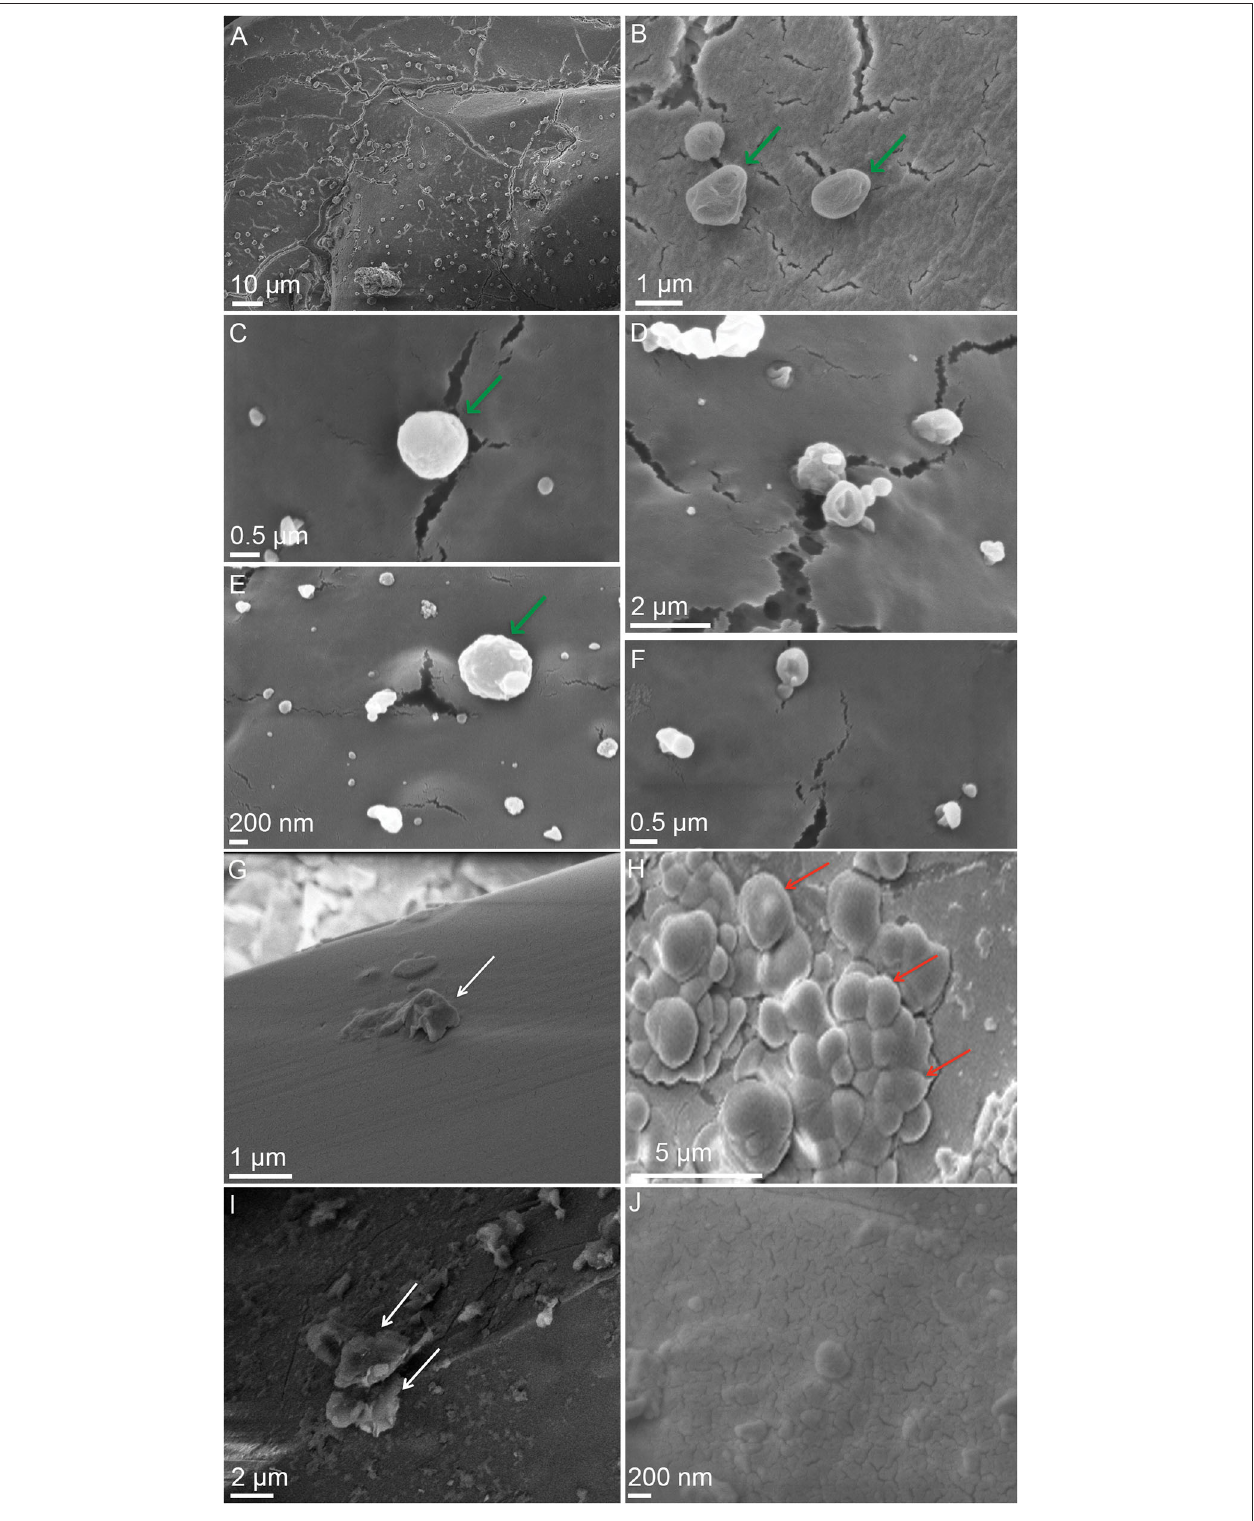
FIGURE 3 | SEM images showing desiccated cells of M. sedula cultivated with the stony meteorite NWA 1172 and surfaces of Martian regolith simulants (MRSs) dehydrated for 2 months after cultivation with M. sedula . (A–F) SEM images of dehydrated M. sedula cells cultivated with NWA 1172. (B,C,E) Magnified SEM